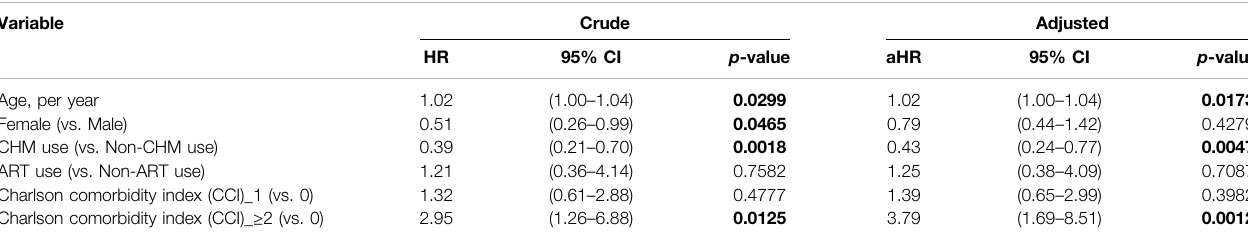
ART, antiretroviral therapies; aHR, adjusted hazard ratio; CI, con fi dence interval; CCI, Charlson comorbidity index; CHM, Chinese herbal medicine; HR, hazard ratio. p - value ( p < 0.05) was shown in bold italic font. Adjusted factors: age, gender, CHM use, and Charlson comorbidity